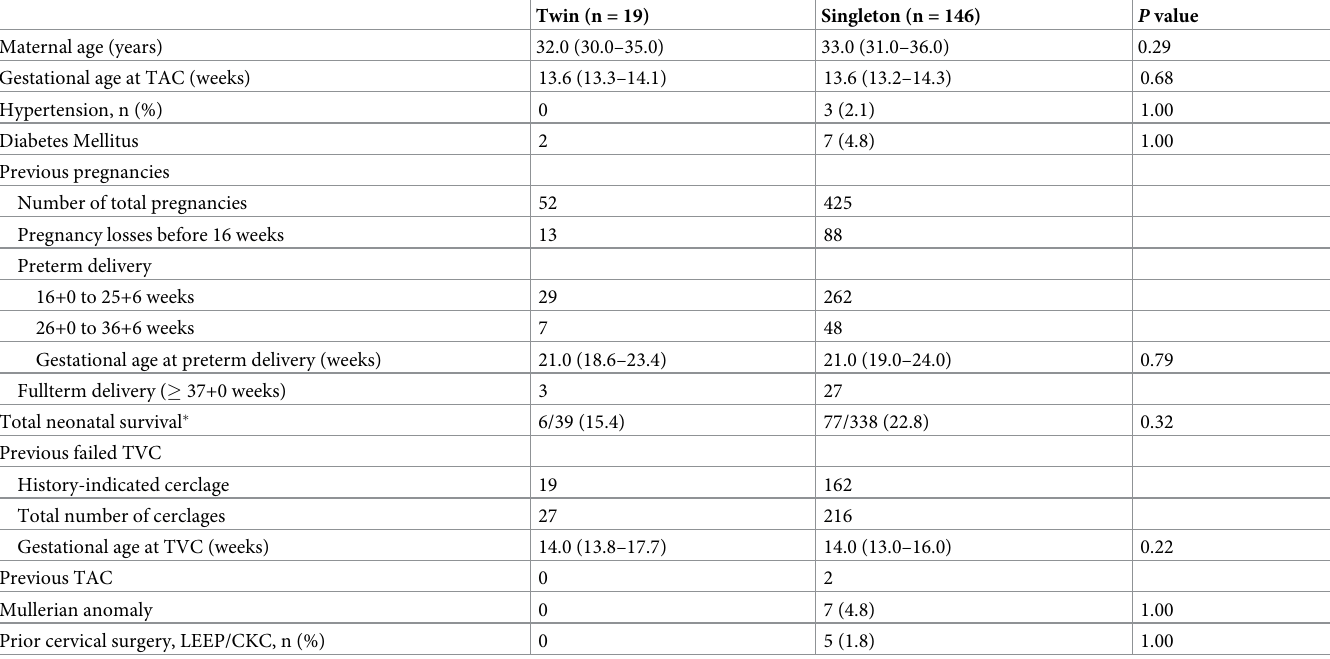
Table 1. Patient characteristics selected for transabdominal